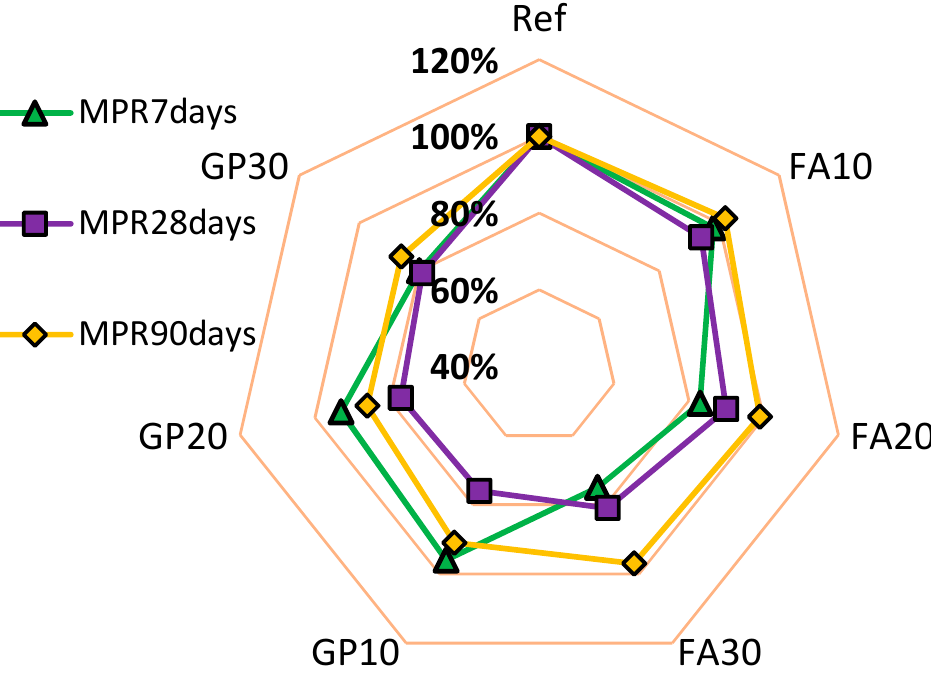
Figure 16. Mechanical performance ratio ( MPR ) value with regards to the type of air-cured cementitious mortar series and the number of days after which the samples were tested.